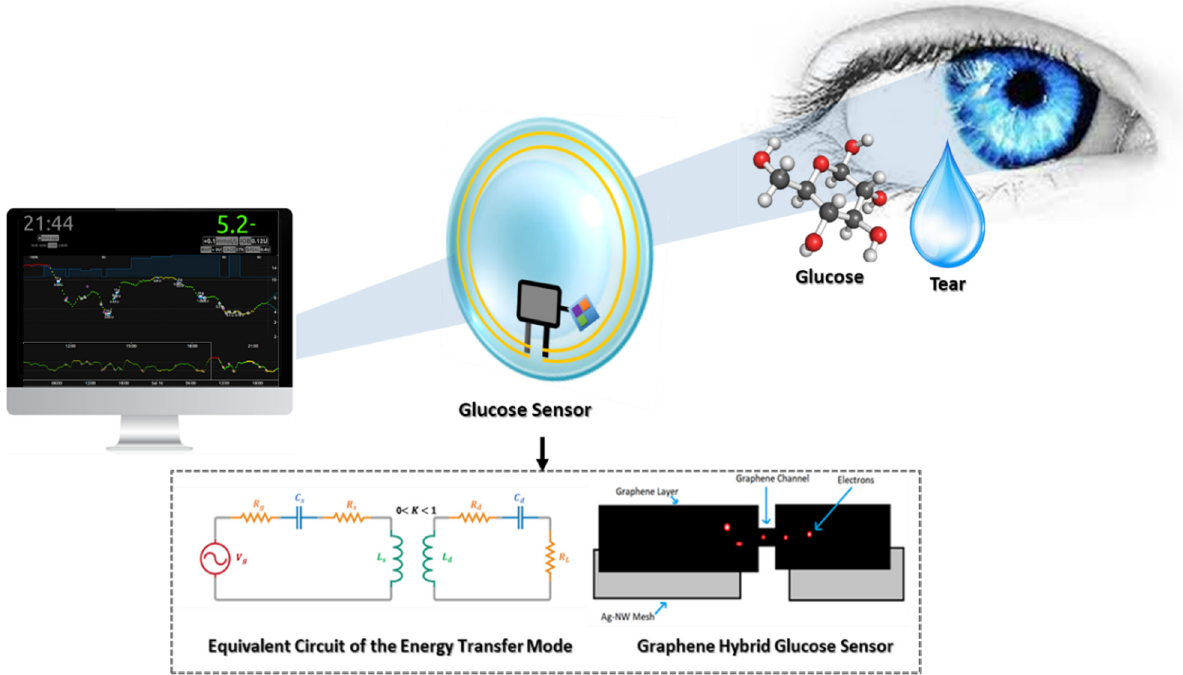
Figure 6. Summary of the key enabling technologies involved in the dynamic, contact lens-mediated glucose sensing pro- cess.